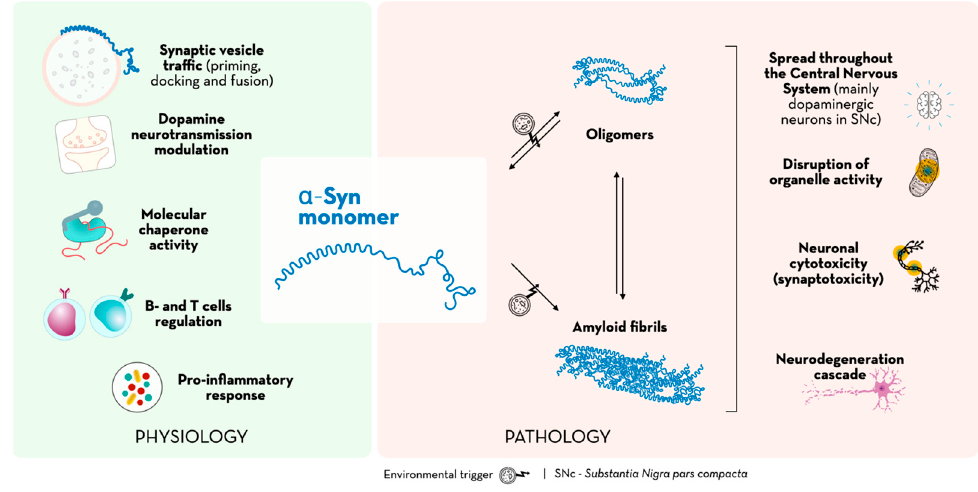
Figure 2. α -Syn’s physiological and pathological paths.